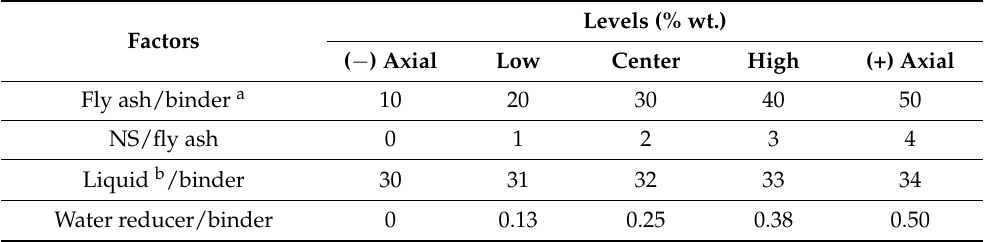
Table 4. Four-factor, two-level central composite design for SMPC mix